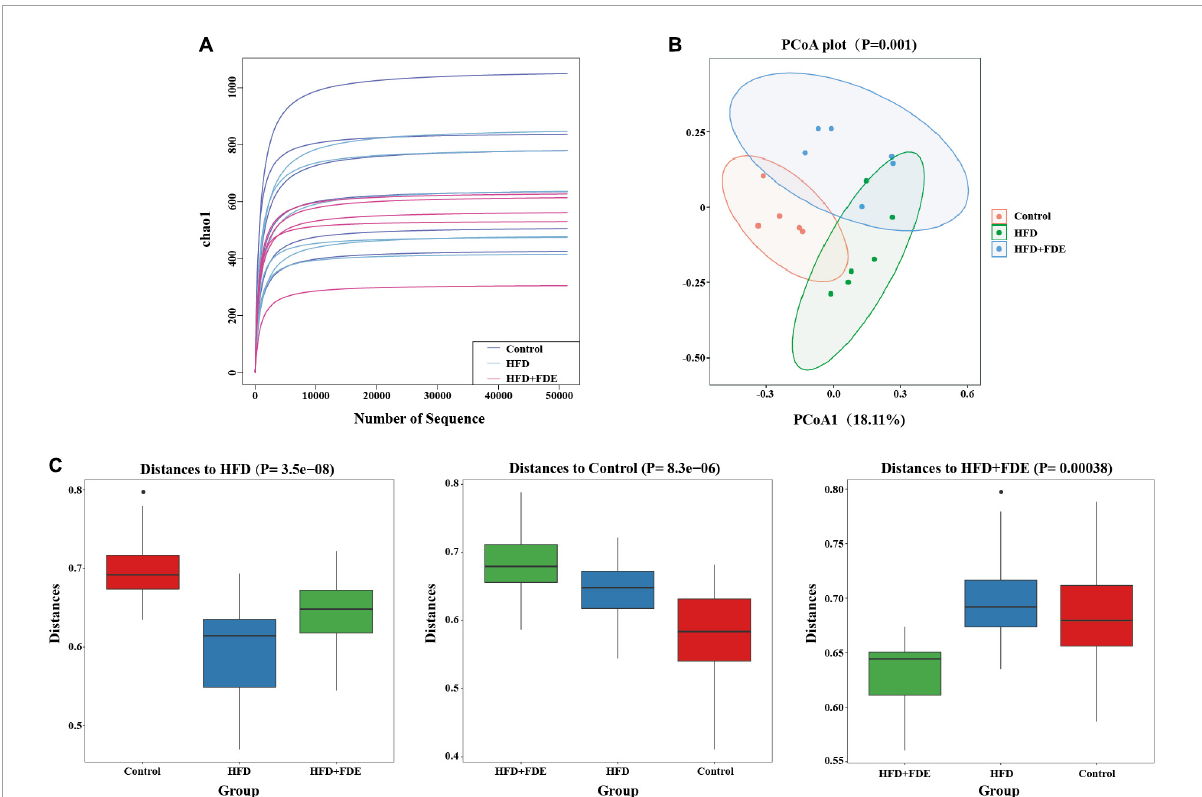
FIGURE5 The composition of the intestinal flora of mice in each group. High-throughput sequencing of 16S rRNA was used to investigate the diversity of intestinal flora in the control, HFD, and HFD + FDE groups. OTU cluster analysis and taxonomic analysis were performed after identification. (A) Rarefaction curves show the species richness of each group using the Chao1 index. (B) The principal components analysis (PCoA) plot shows the similarity of microbial composition between samples. (C) Box plot showing the similarities or differences between groups. n = 5–6 per group. Control, normal diet; HFD, high-fat diet; Control + FDE, a mixture of FDE and normal diet; HFD + FDE, a mixture of FDE and high-fat